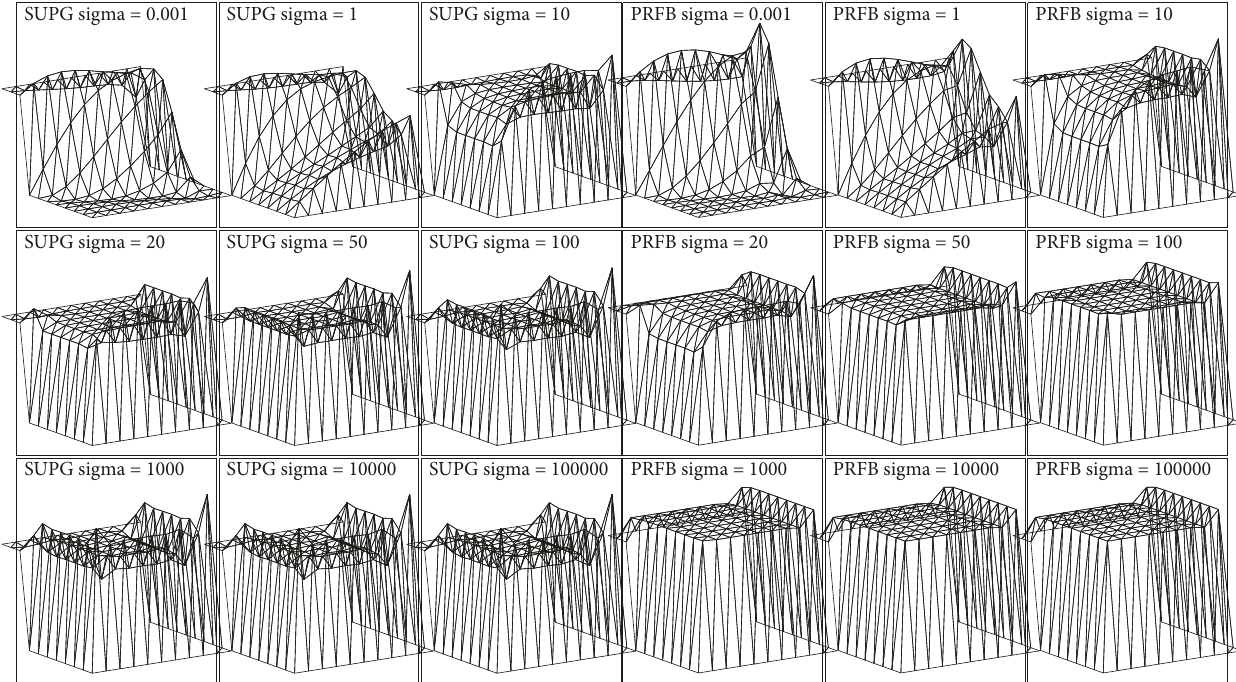
Figure 10: Numerical solutions for 𝜃 = 72 ∘ , 𝜖 = 10 −4 , and 𝑁 = 10 .